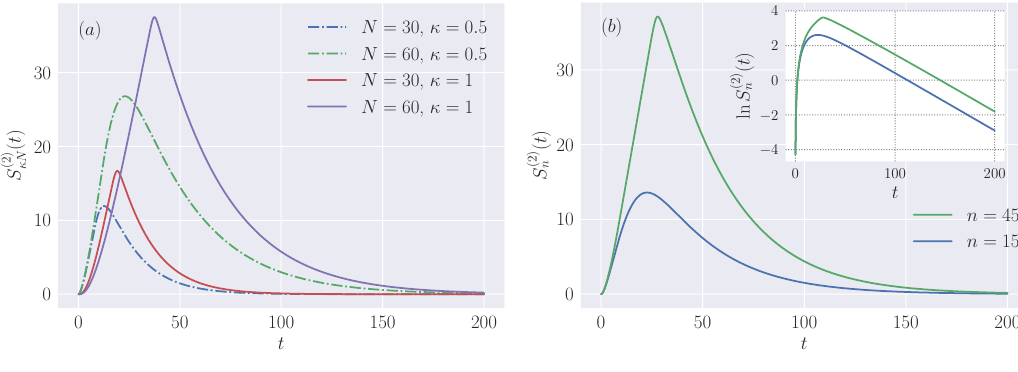
Figure 5 . R(cid:19)enyi entropy S (2) n ( t ) as a function of time for (cid:21) 1 = 1 and (cid:21) 2 = 2. The plots correspond to a random evolution in the presence of a global U(1) conserved charge, while the system is initialized as in eq. (3.18). Sub(cid:12)gures ( a ): S (2) ( t ) for di(cid:11)erent values of the system size N and (cid:20)N (cid:20) = 0 : 5 ; 1. Sub(cid:12)gure ( b ): S (2) n ( t ) for N = 60 and subsystems containing 15 and N 15 = 45 qubits. (cid:0) Inset: ln S (2) n ( t ) for the same values of n .